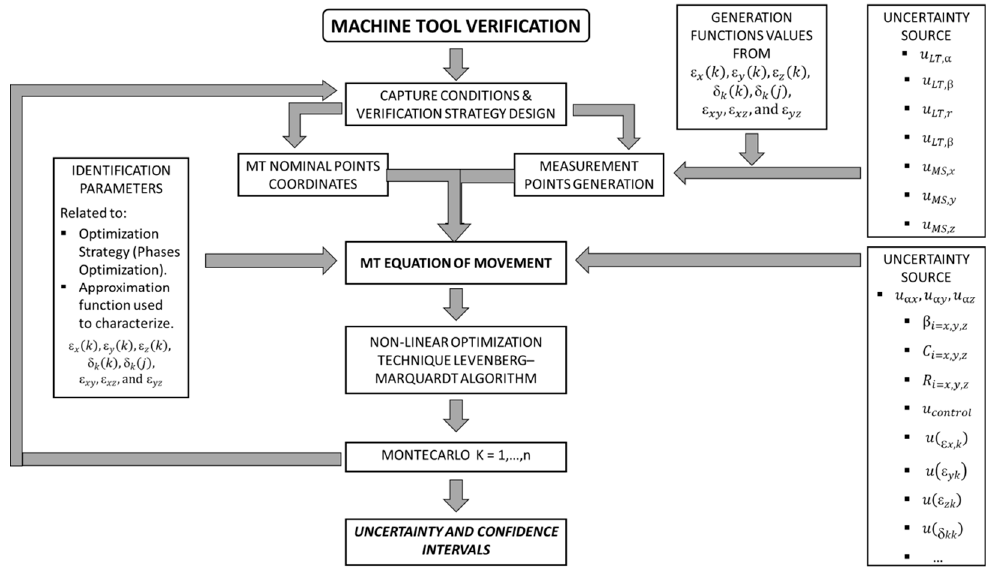
Figure 8. Uncertainty evaluation and confidence intervals of the parameters.